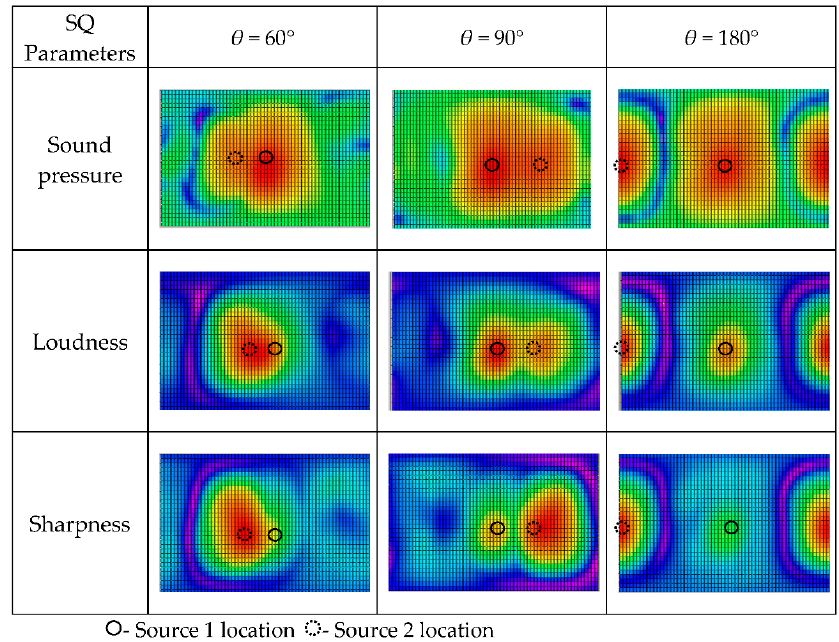
Figure 11. Spatial distributions of sound quality objective parameters varying with intersection angle for source frequen- cies f 1 = 1000 Hz and f 2 = 1200 Hz, and reconstruction distance r = 0.1 m. (The results are shown in the form of plane angle for source frequencies f 1 = 1000 Hz and f 2 = 1200 Hz, and reconstruction distance r = 0.1 m. expansion of the spherical calculation surface, and the horizontal axis is longitude: −π ~ π , the vertical axis is latitude: (The results are shown in the form of plane expansion of the spherical calculation surface, and the −π /2~ π /2). horizontal axis is longitude: − π ~ π , the vertical axis is latitude: − π /2~ π